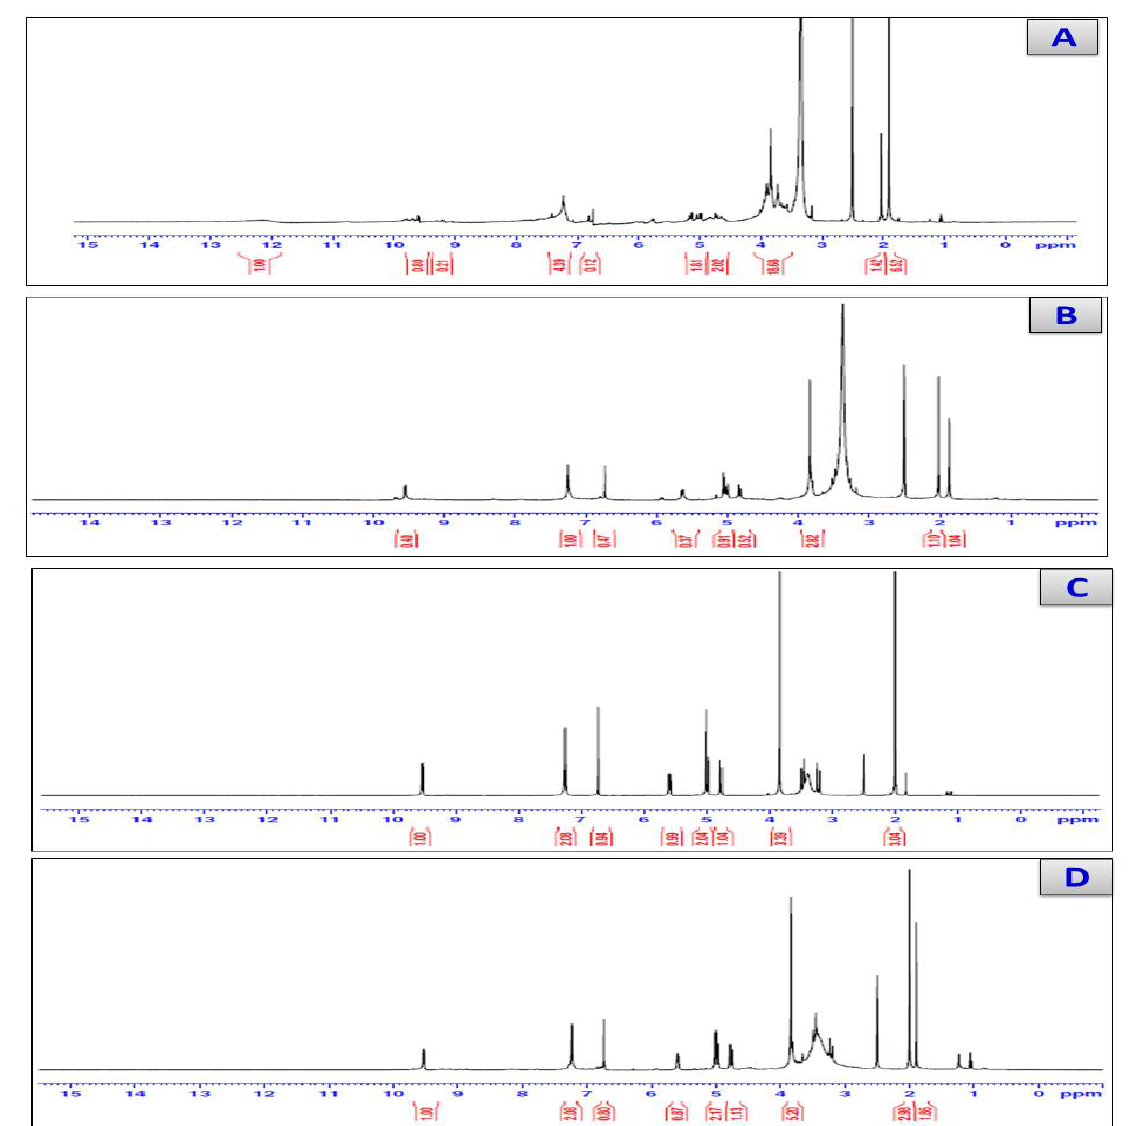
Figure 3. 1 H-NMR spectra of ( A ) Cfotax, ( B ) cefotax/Ca, ( C ) cefotax/Zn, and ( D ) cefotax/Se.